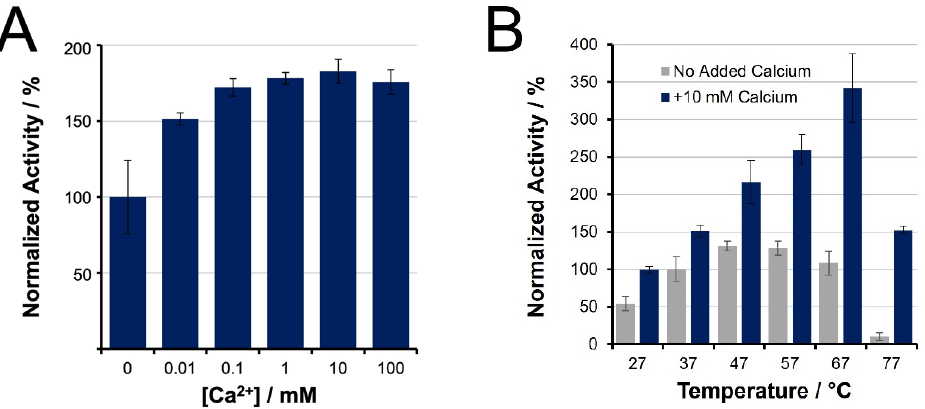
Figure 1. Initial trypsin activity of unmodified, TPCK-treated trypsin, as determined by BAEE assay, and normalized to activity at 37 ◦ C in the absence of calcium. ( A ) Activity increases with addition of CaCl 2 ; ( B ) Initial activity at increasing temperatures, showing the benefits of Ca 2+ for higher temperature incubation.